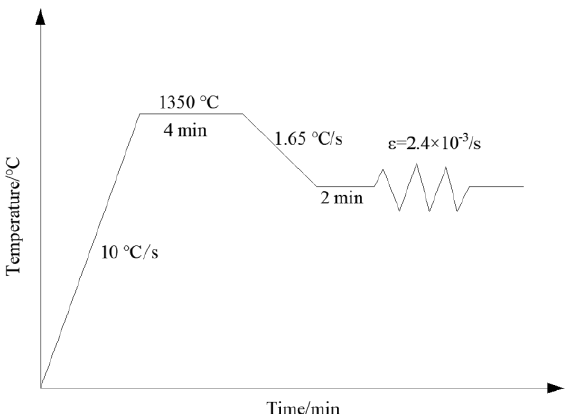
Figure 2. Schematic diagram of the simulated heat treatment scheme for the steel investigated.